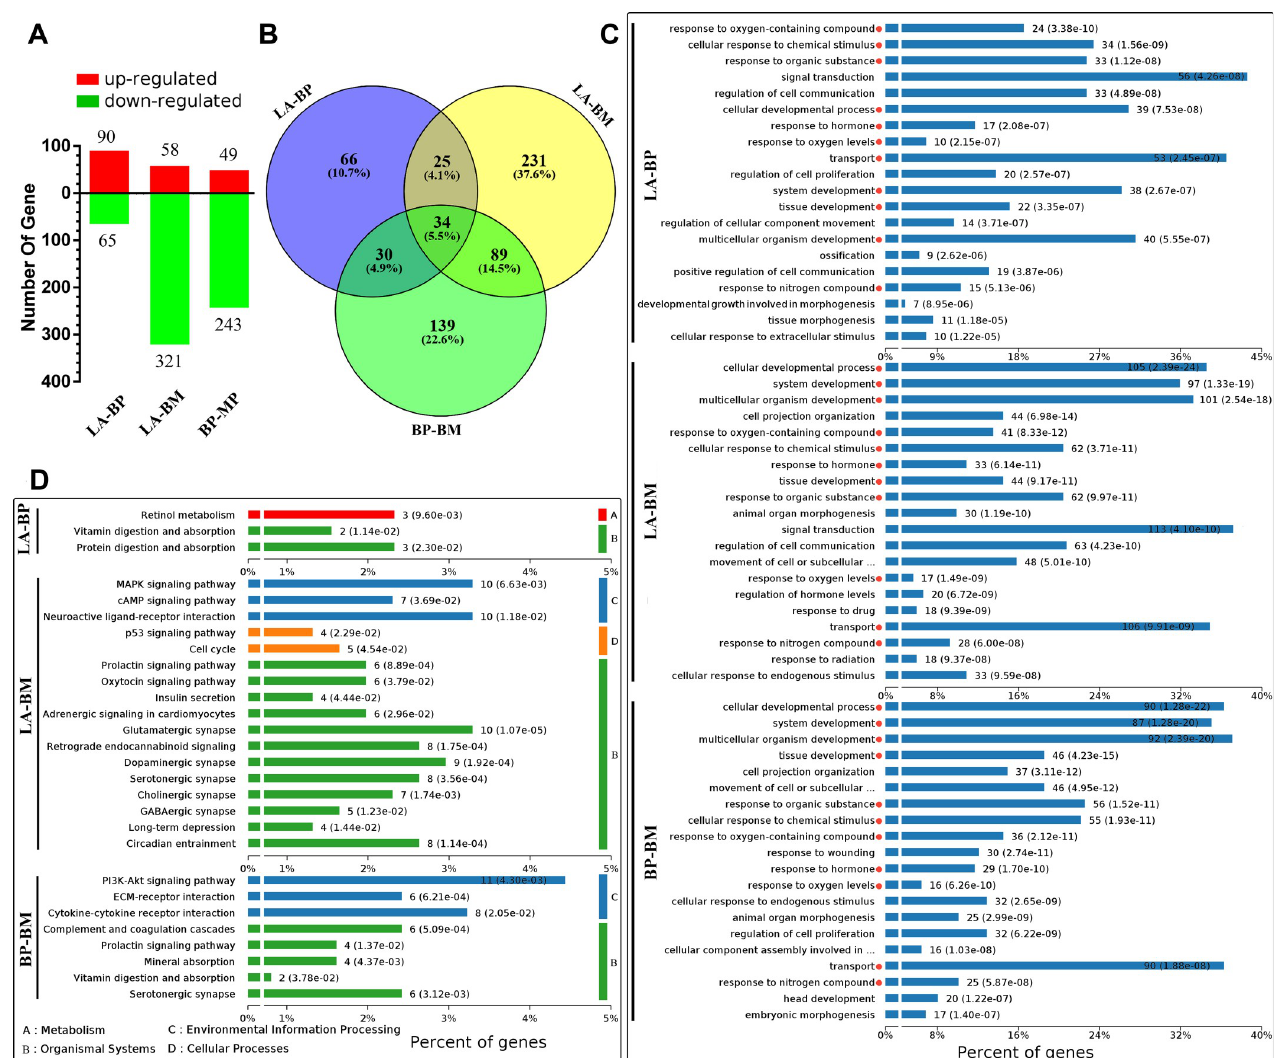
Fig 2. Statistical results, GO enrichment and KEGG enrichment of different expressed genes (DEGs). (A) Histogram of DEGs in pairwise comparisons of three group. Red bar for up-regulated genes, green bar for down-regulated genes. (B) Venn diagrams of DEGs in pairwise comparisons of three group. (C) Top 20 significantly enriched Biological processes of GO enrichment of DEGs in three comparisons. (D) The significantly enriched KEGG pathways of DEGs in three comparisons.